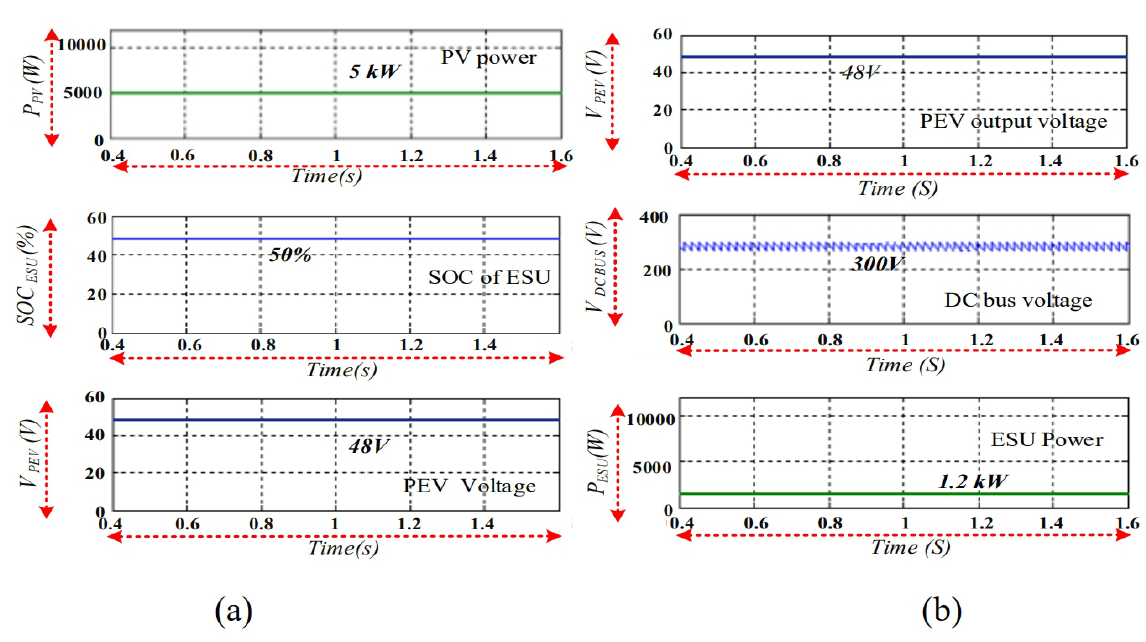
Fig. 6. (a) PV to PEV charging output, (b)PEV to ESU mode output.